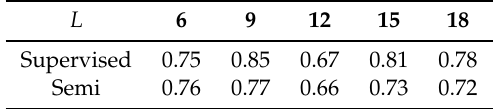
Table 12. Sensitivity Analysis (L).